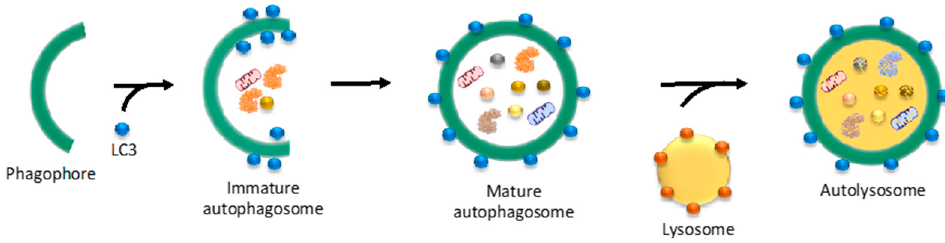
Figure 5. The autophagy-lysosome system. Autophagy, or macroautophagy, starts with the formation of a double membrane structure known as the phagophore, which can be either newly synthesized or originated from the plasma membrane, ER or mitochondria. The ULK complex (formed by, among others, ULK1/2, ATG13, FIP200 and ATG101) regulates this first step of autophagy. Then, the VPS34-BECN1 complex (formed by VPS34, BECN1, AMBRA1, ATG14L and other proteins) promotes the expansion of the phagophore. Once the cytoplasmic fraction is engulfed into the phagophore, the membrane elongates until it closes forming the autophagosome, a process regulated by the ATG12-ATG5-ATG16L1 complex. Conjugation of cytosolic LC3 (LC3I) to phosphatidylethanolamine generates LC3II, which is recruited to the membrane of the autophagosome. Finally, LC3II-containing autophagosomes are trafficked to the lysosome for degradation of their content including polyQ-expanded aggregates.